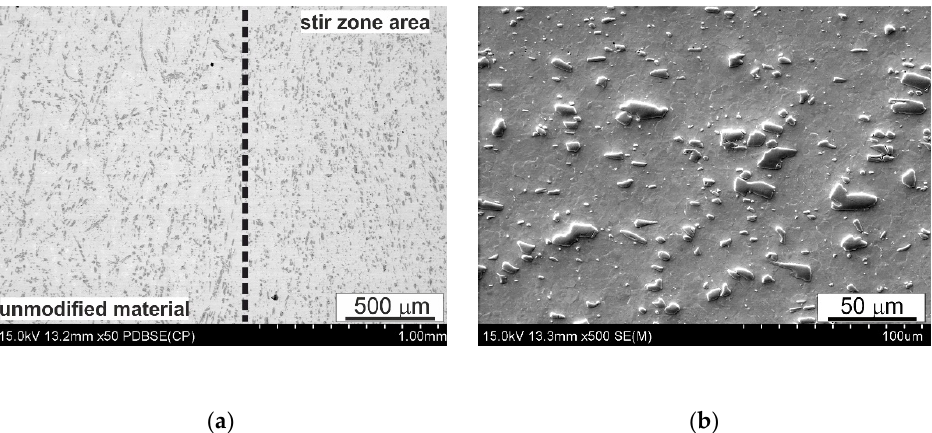
Figure 5. Microstructure of SnSb9Cu4 alloy after FSP; 280 RPM; ( a ) figure show both the zone after pin passage and the area without modification, ( b ) figure show stir zone area.